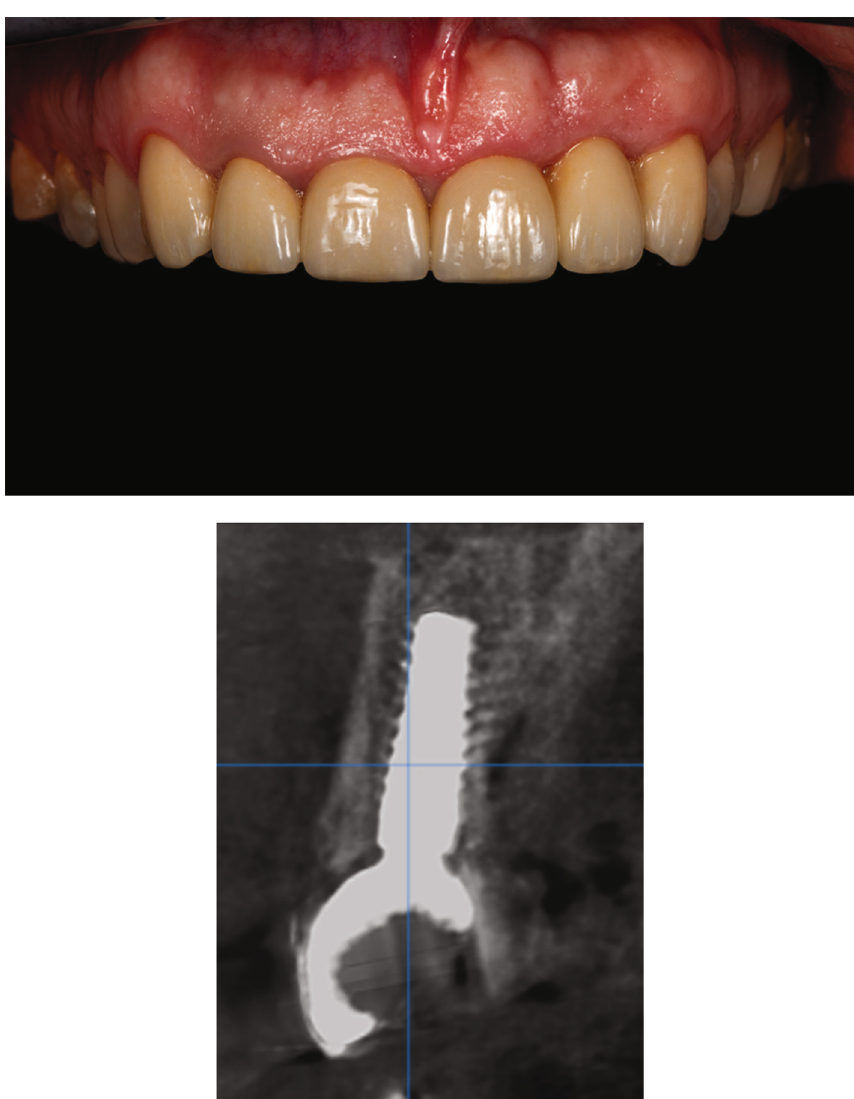
Figure 12: The fi nal restoration in place with control CBCT after 2 years post-operative.